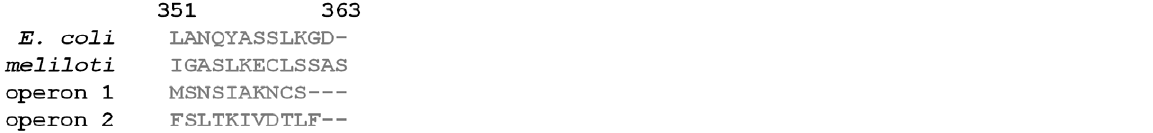
Table 3. Sequence comparison of the Znu proteins from Ca. Liberibacter asiaticus vs. Ca. Liberibacter solanacearum.